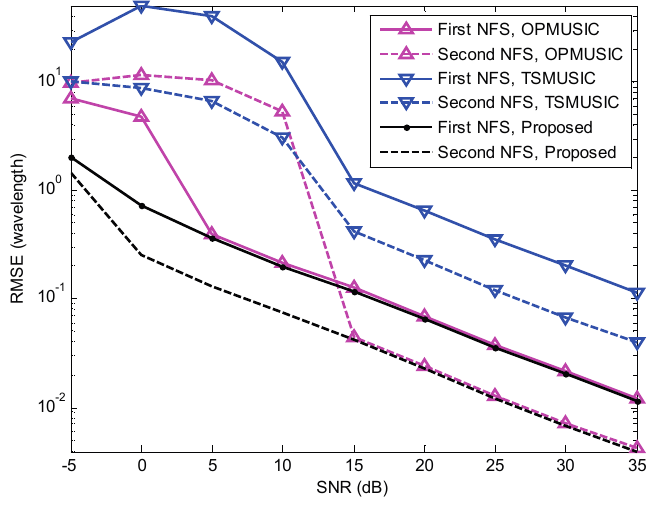
Figure 7. RMSEs of NFSs range estimates versus